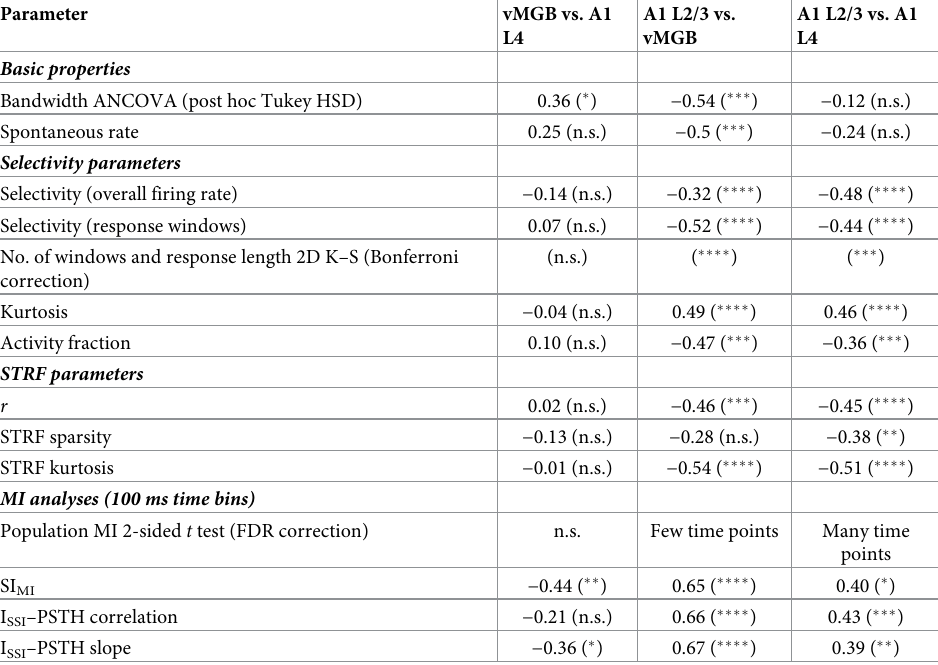
Table 1. Statistical summary of comparisons between vMGB, A1 L4, and A1